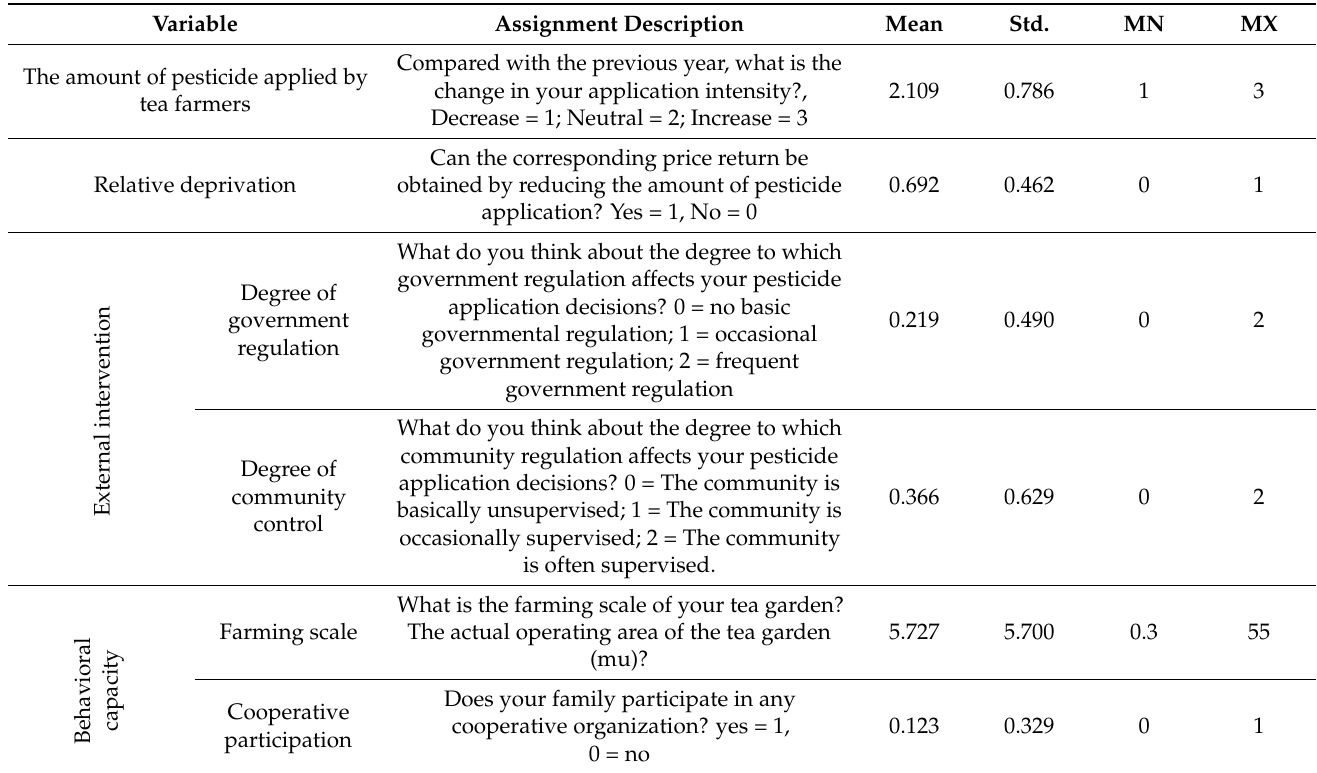
Table 1. Variable meaning and descriptive